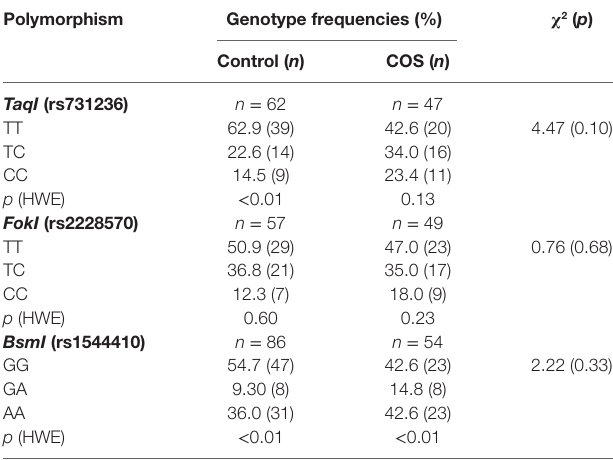
TaBle 3 | Genotype frequencies of VDR polymorphisms.